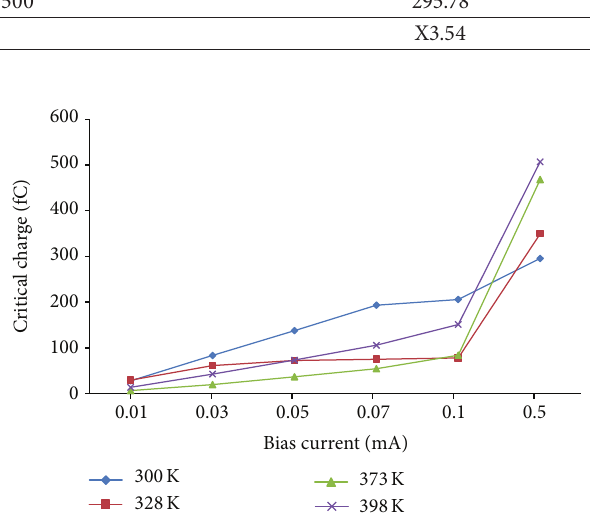
Figure5:Criticalchargeagainstbiascurrentsfordifferentoperating temperature at 0.5 GHz and 𝑉